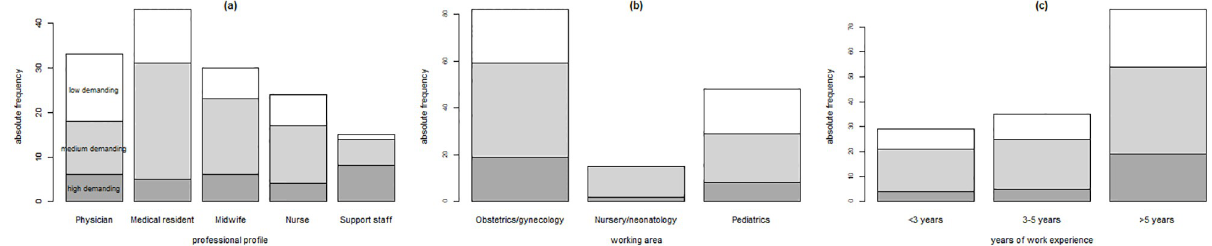
Fig 3. Distribution of clusters of health professionals (i.e., high, medium, and low demanding clusters) grouped by professional profile, working area, and years of work experience.